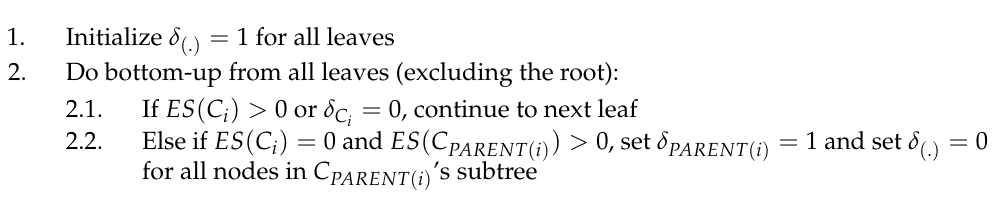
Algorithm 1 Selecting epsilon stable clusters from the